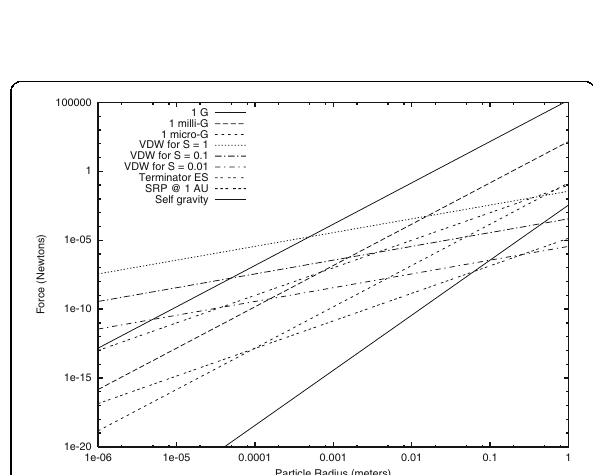
Fig. 15 Magnitude of different forces compared to gravity as a function of particle radius (from Scheeres et al. 2010). VDW expresses van der Waals force, and S is the surface cleanness (S goes to 1 for clean surfaces). Ryugu ’ s ambient gravity is estimated of the order of 0.25 m G